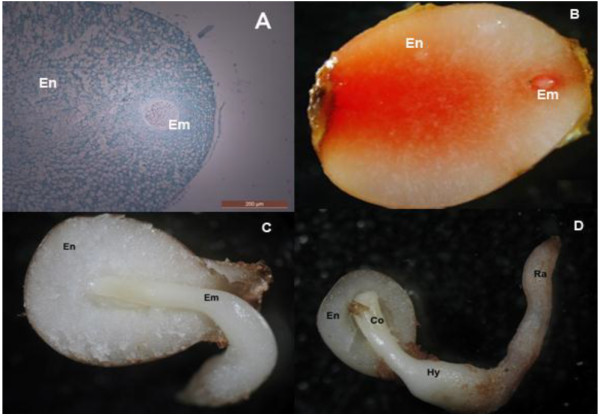
Relative expression levels analysis of four circadian rhythms related transcipts (ELF1, ELF2, SFR6, SUS) in the Embryo (Em□) and endosperm (En■) under warm (20°C)/cold (4°C) seed stratification process. RS, radical just sprouted; RG, radical growing up to 2 cm. Expression is shown relative to GAPDH as the reference gene. RNA was extracted from three biological samples and qRT-PCR was performed. Data represent means ± SD. * indicate a significant difference between Em and En at P < 0.05.